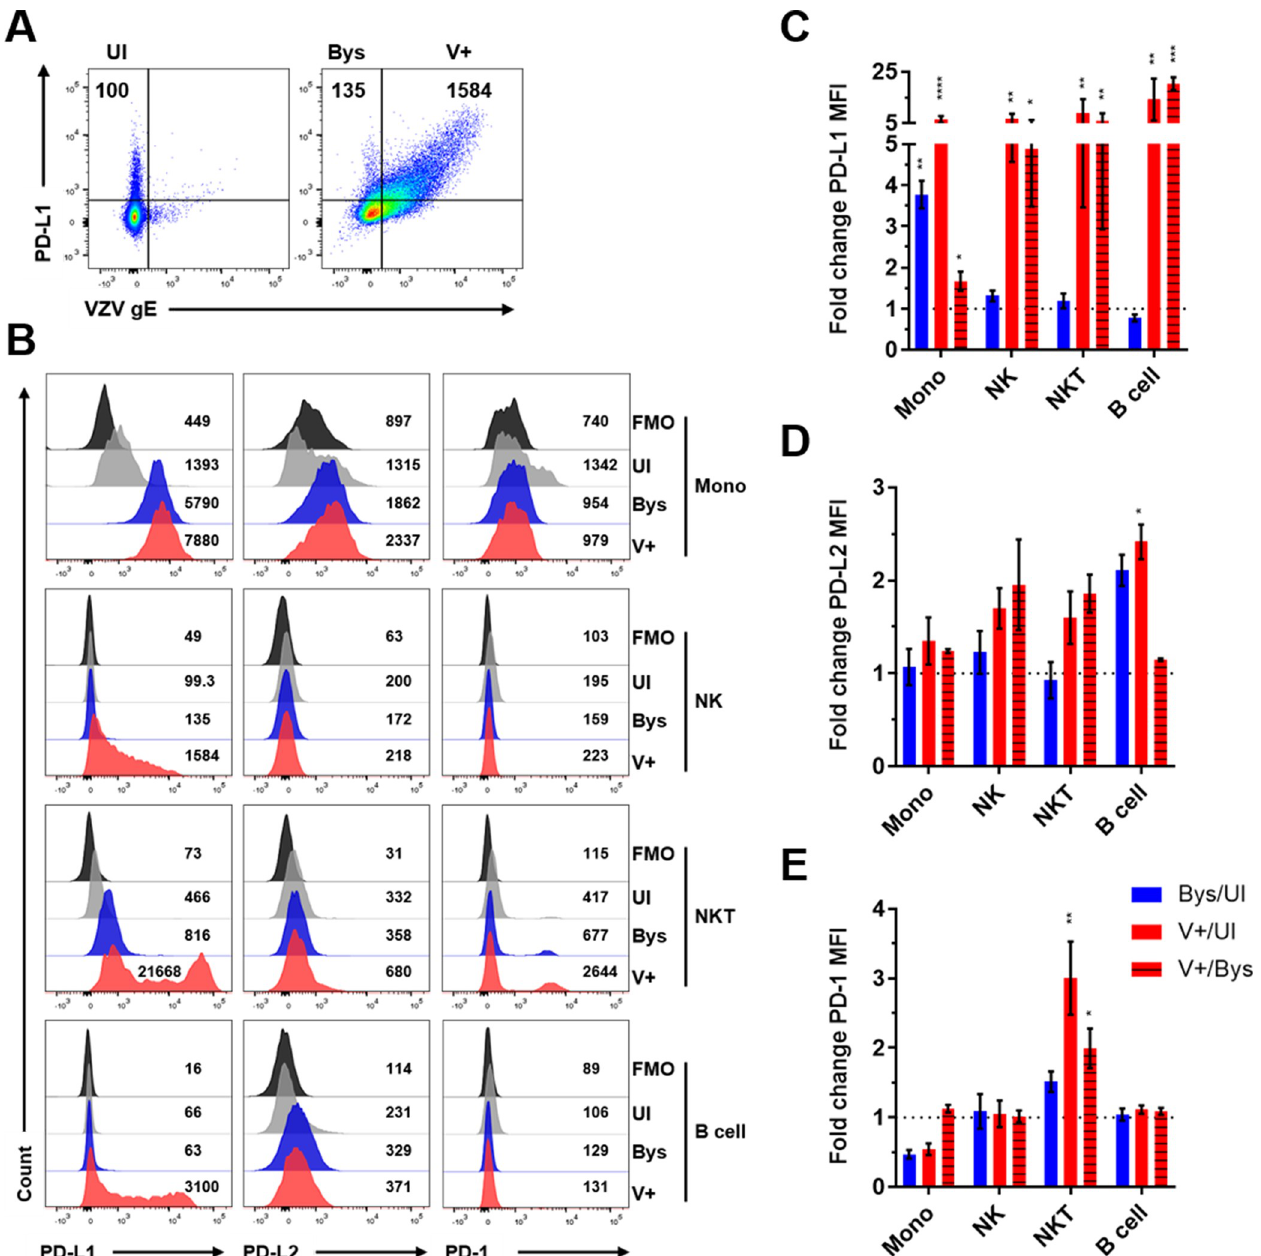
Fig 5. VZV-mediated regulation of PD-L1, PD-L2 and PD-1 expression in human monocytes, B cells, NK cells and NKT cells. Human PBMCs were co- cultured with uninfected- or VZV-infected HFLs for 48 h as described in Fig 1 then harvested and analyzed for PD-1, PD-L1, PD-L2 and VZV gE expression using flow cytometry. (A) Flow cytometry gating strategy for uninfected (UI), VZV gE-negative bystander (Bys) and VZV gE+ (V+) immune cell populations. (B) Representative flow cytometry plots of PD-L1, PD-L2 and PD-1 MFI expression levels in monocytes (Mono), NK cells, NKT cells and B cells. Black histograms = FMO control, grey histograms = UI, blue histograms = Bys and red histograms = V+ cells. (C-E) Summary of fold change in MFI in PD-L1 (C) , PD-L2 (D) and PD-1 (E) expression levels in: Bys/UI (blue), V+/UI (red) and V+/Bys (red with black stripes) with respect to all immune cell populations analyzed. Results are representative of eight independent experiments with PBMCs from eight healthy individuals. Bar graphs represent average fold-change in MFI ± SEM. � P < 0.05, �� P < 0.01, ��� P < 0.001, ���� P < 0.0001. Statistical significance was determined using RM one-way ANOVA with the Greenhouse- Geisser correction and Tukey